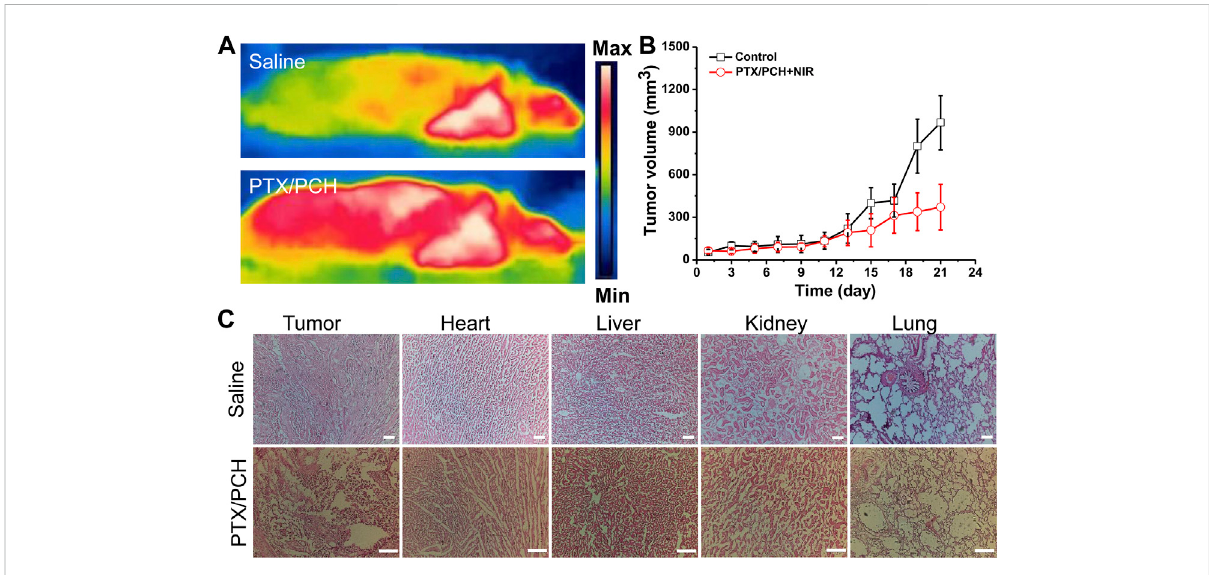
FIGURE 7 (A) Thermal images of the animals treated with saline (NIR) or PTX/PCH (NIR). (B) Tumor volume changes. (C) The H&E assay